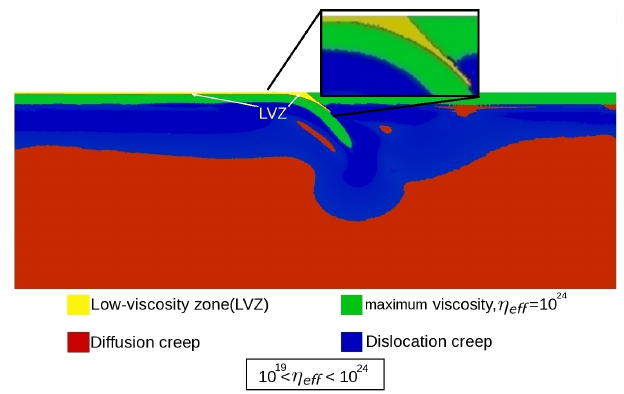
Fig. 3. Dominant deformation mechanism in the initial model with open side boundaries of Fig. 1a. Different colours correspond to regions where the individual deformation mechanism are